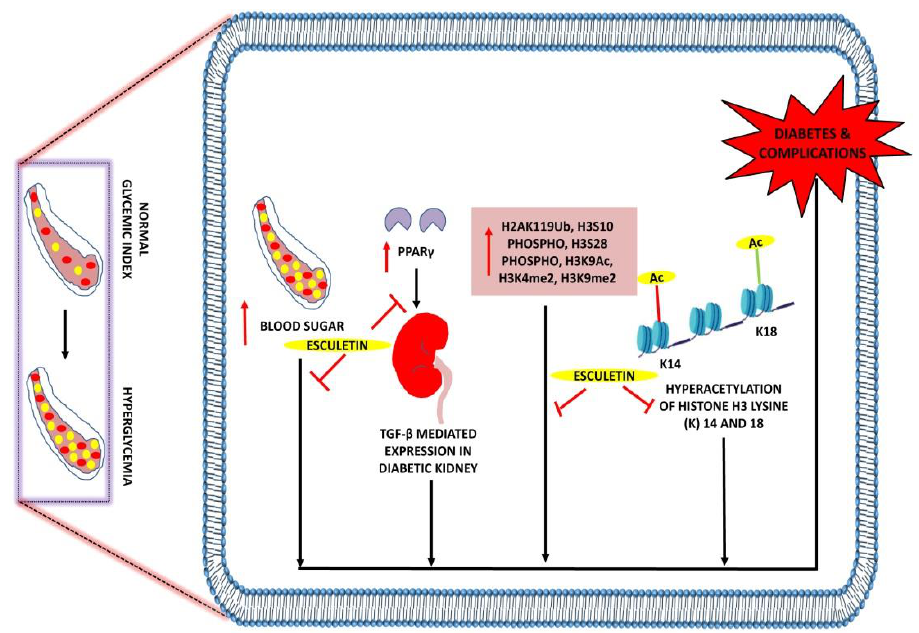
Figure 6. Anti- diabetic effects of esculetin: Esculetin downregulates the expression of PPARγ, H3S10phospho, H3S28phospho, H3K9Ac, H3K4me2, and H3K9me2, hyperacetylation of histone H3 lysine (K) 14 and 18 and attenuates diabetes and its associated complications. ↑ : Overexpression; (cid:97) : inhibition. • : RBC; • :